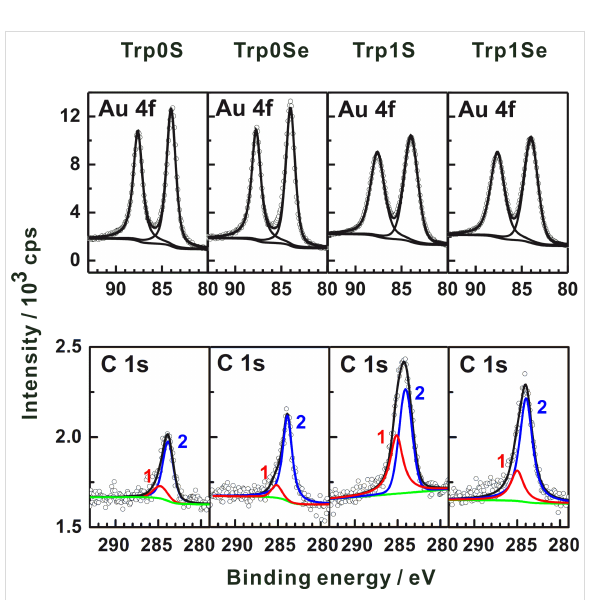
Figure 3: XP spectra of triptycene-terminated thiolate- and selenolate- monolayers on Au(111). See text for